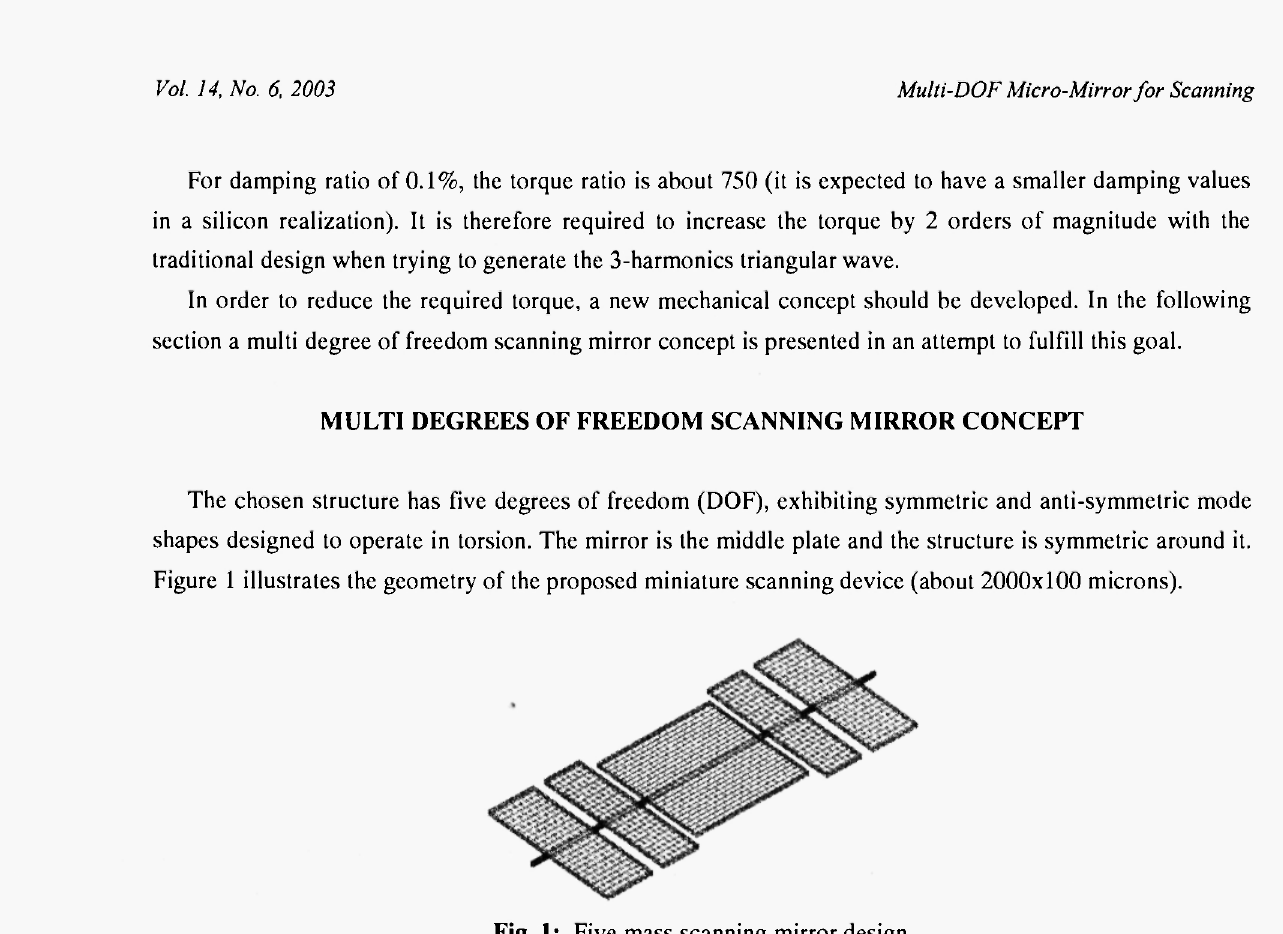
Fig. 1: Five mass scanning mirror design.